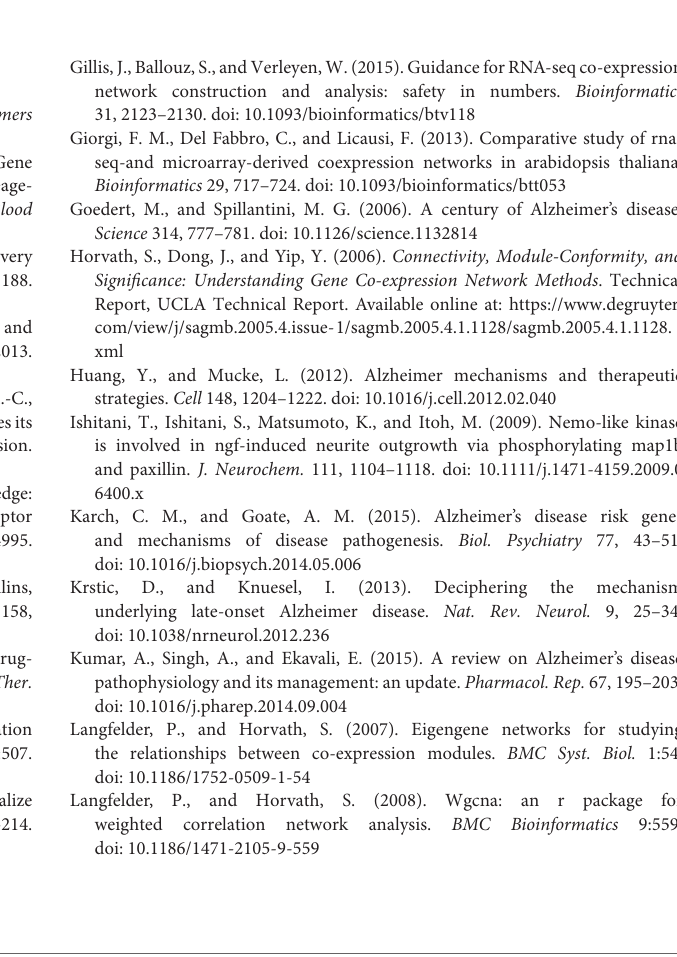
Figure S5 | Mouse may have divergent co-expression profile with human AD samples. Figure S6 | The association between dysregulation and connectivity in the co-expression network. The y-axis shows the median z-score of the differential co-expression. Figure S7 | The partner number of dysregulated genes predicted using RNA-seq and microarray data. Figure S8 | The association between connectivity and co-expression correlation. (a) the genes with higher connectivity are always the genes with higher co-expression correlation. (b) Functional annotation to the top 200 genes with the highest connectivity. Table S1 | The 87,539 dysregulated gene pairs between AD and normal. Table S2 | All the dysregulated genes with at least one partner. Other annotation including differentially expressed in AD samples, aging related genes, AD genes, connectivity in co-expression network. Table S3 | The Alzheimer’s disease related genes collected by text mining to the published works. Table S4 | The differentially expressed genes in AD patients. Table S5 | The association between dysregulated genes and clinical traits. Table S6 | The used microarray data for mouse brain. Table S7 | The used microarray data for human brain. Table S8 | The dysregulated genes and the WGCNA analysis